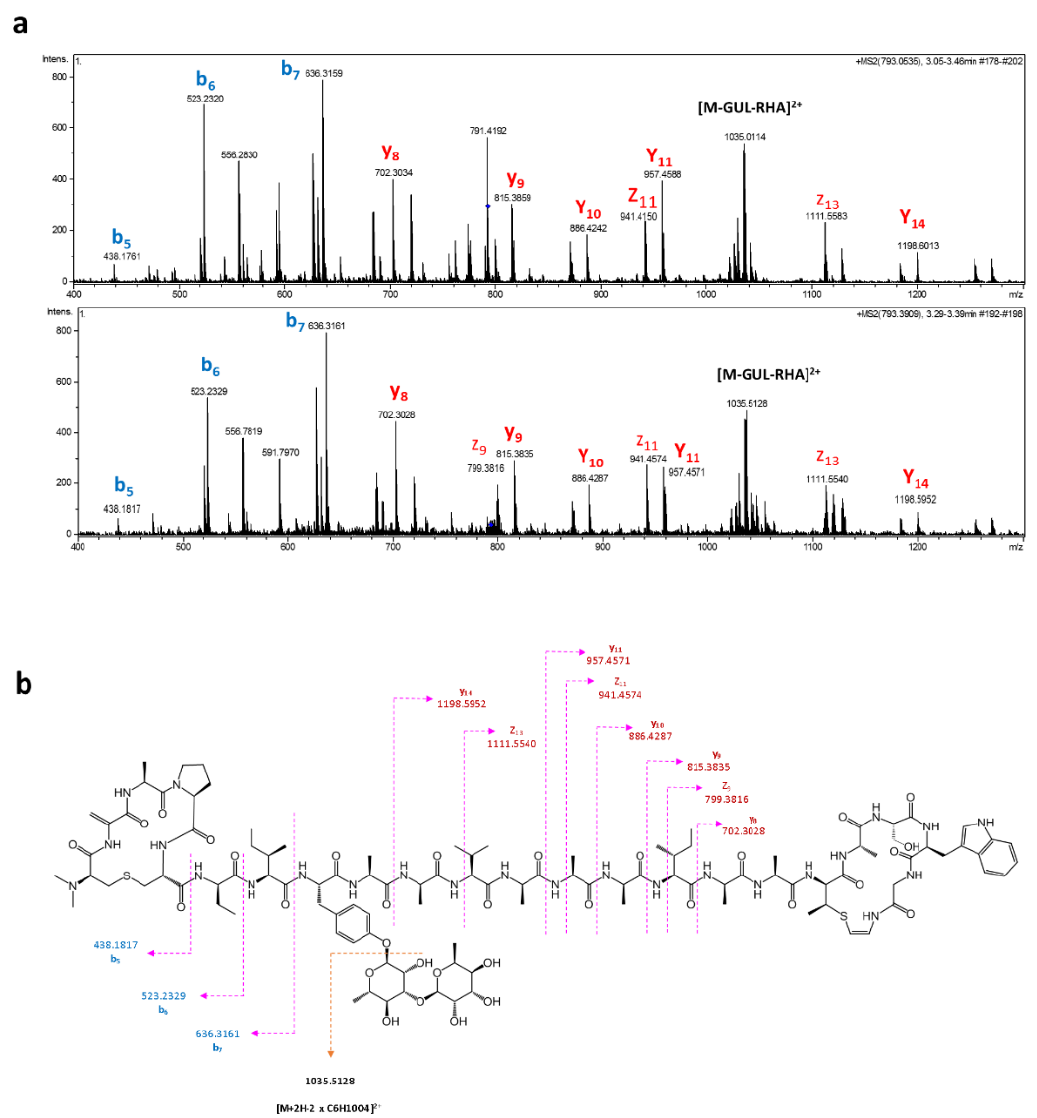
Figure 4. ( a ) Tandem MS/MS fragmentation pattern of C 107 H 162 N 24 O 32 S 2 + NH 4+ + 2H + from strain CA-170360 ( top ) and S. albus J1074/pCAO ( bottom ). Annotation of b-, y- and z-ions is shown. ( b ) Key MS/MS fragmentation of [M + 2H + NH 4 ] 3+ ion.